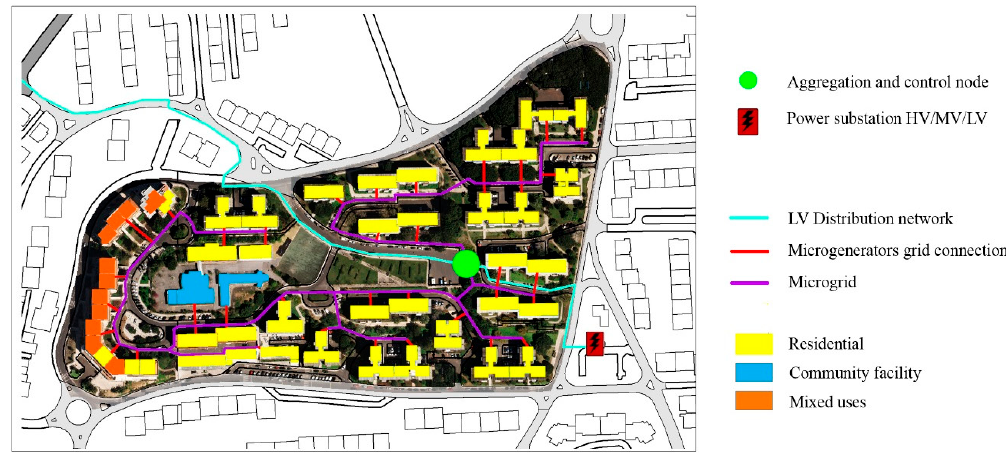
Figure 4. Layout of ‘Produces and Shares’ scenario.